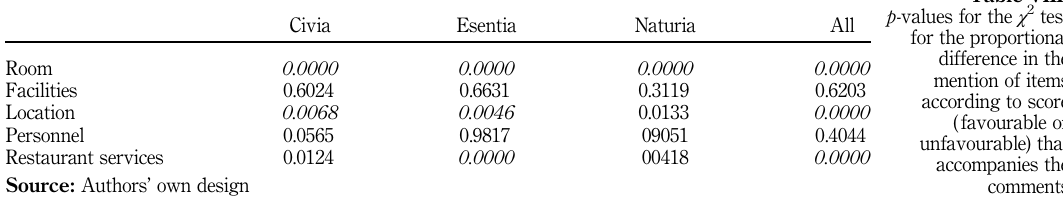
Table VIII. p- values for the χ 2